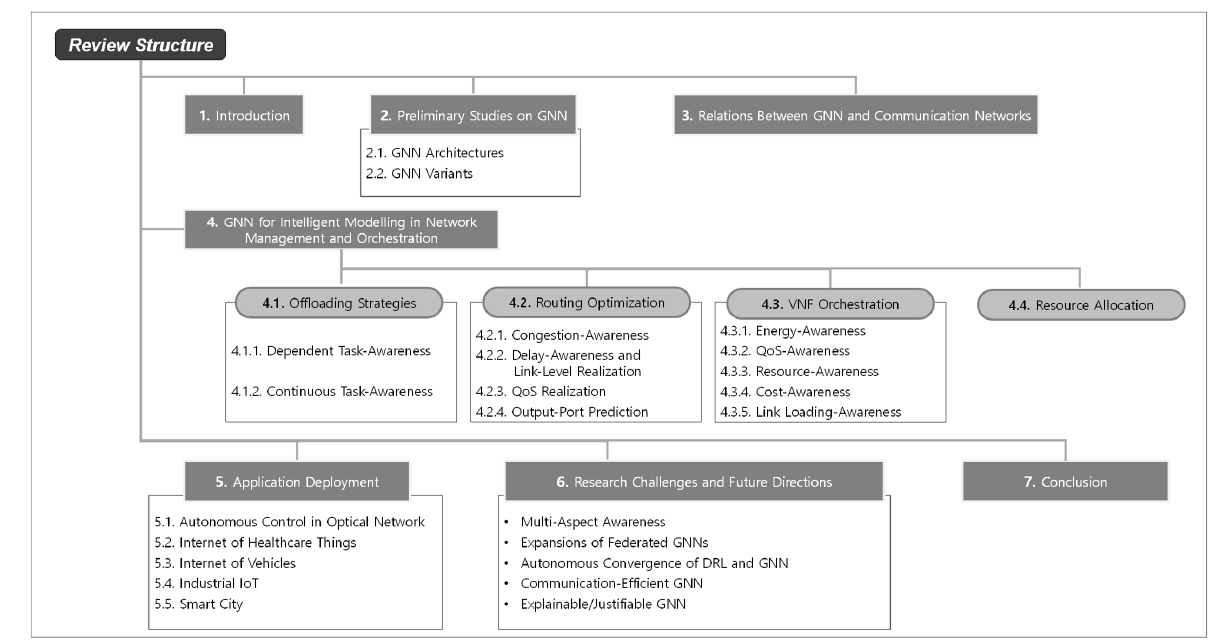
Figure 1. Structure of this paper. Table 1. List of Important Acronyms.